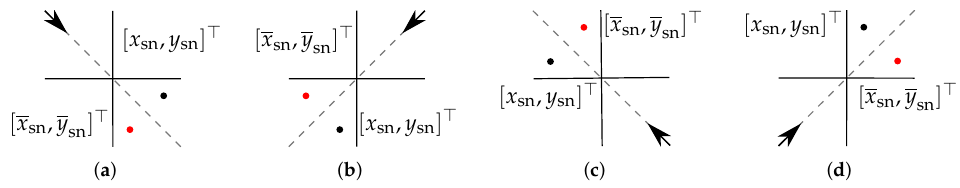
Figure 7. Exploitation of the symmetry in terms of the surface normal coordinates. ( a ) Applying a kick from the hind left (depicted as arrow) with current state [ x sn , y sn ] (black dot) leads to the ] , mirrored at the diagonal axis (red dot). ( b – d ) The same identical motion as for a state [ x sn , y sn relative behavior is obtained when the state and kick direction are rotated and mirrored accordingly. Thus, all combinations of states and kick directions can be determined, given the motion of each state within the upper right half-space when applying a kick from the hind left is